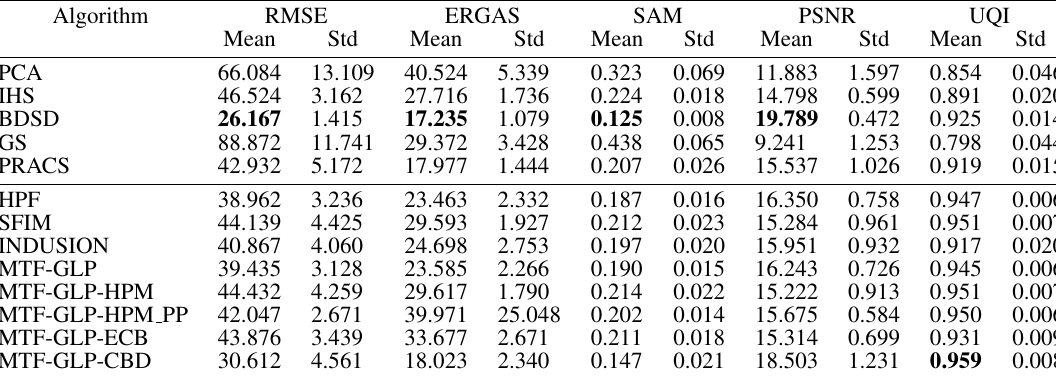
Table 3. Quality indices for the False Colour Thermal Pansharpened images from the Illescas UAV dataset for each